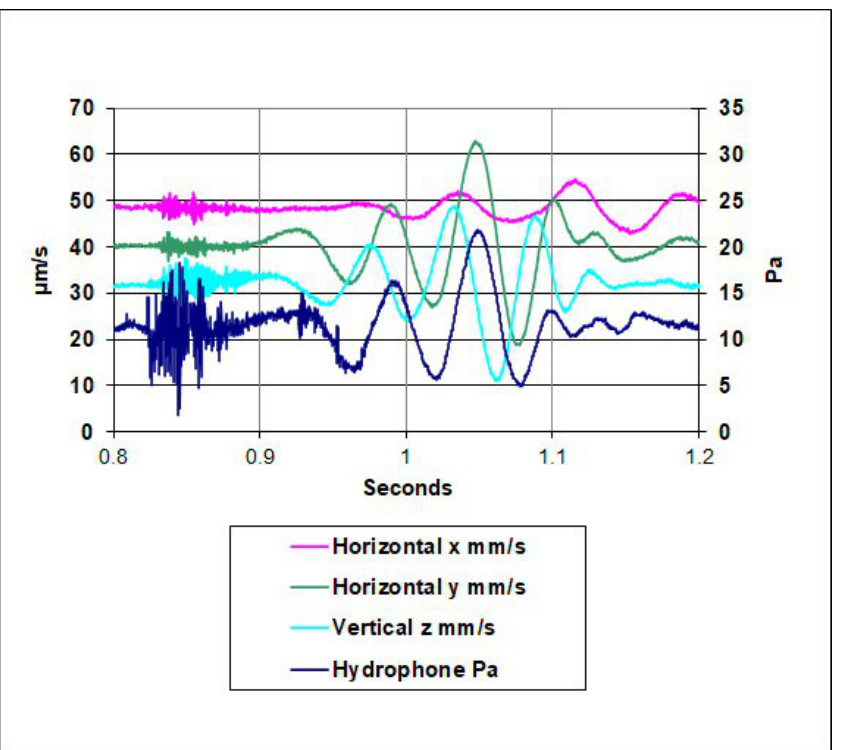
Figure 15. Test results from the trial showed three velocity components and the acoustic pressure. The right side vertical scale applies to the hydrophone pressure data, the left side to the geophone water-motion data. The plots are offset for clarity. The recorded values returned to zero after the wave had passed.